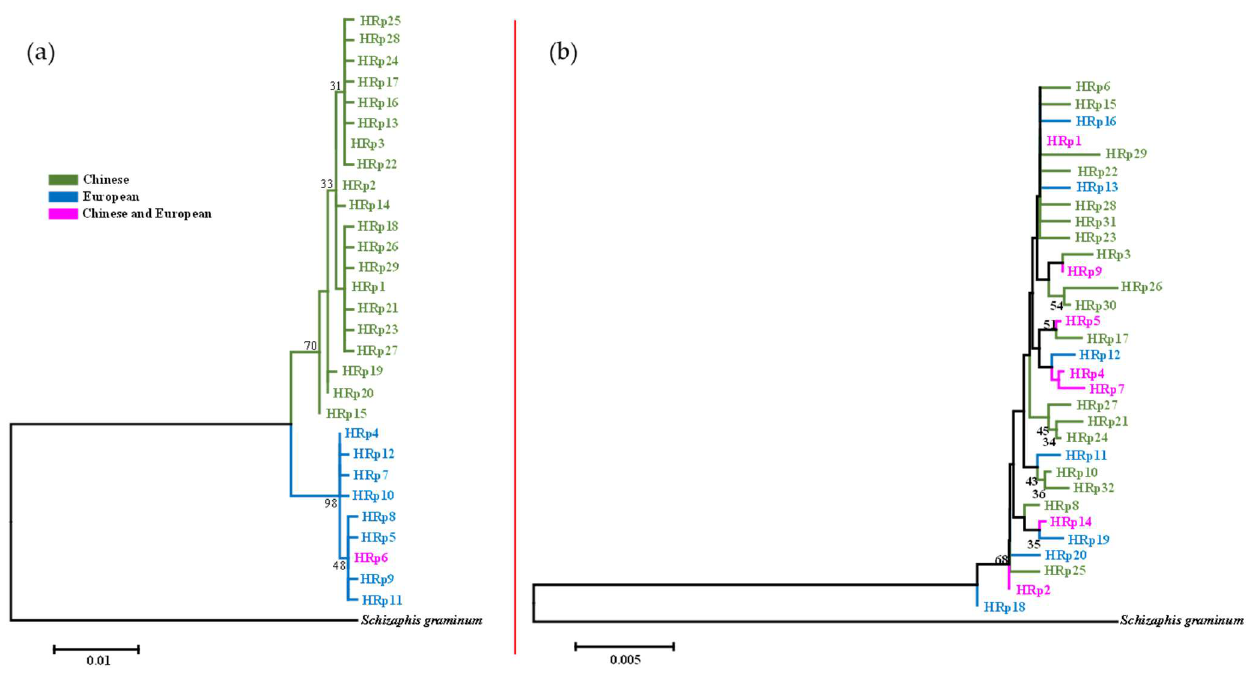
Figure 4. Maximum likelihood (ML) tree showing phylogenetic relationships of R. padi with bootstrap support (1000 replicates). ( a ): The 29 haplotypes of combined COI and COII genes (995 nt); ( b ): 32 haplotypes of EF−1α gene (672 nt). HRp: haplotypes of R. padi . Schizaphis graminum (accession number: HQ392586 for COI, U36751 for COII, and AY219720 for EF−1α) was used as the outgroup insect.